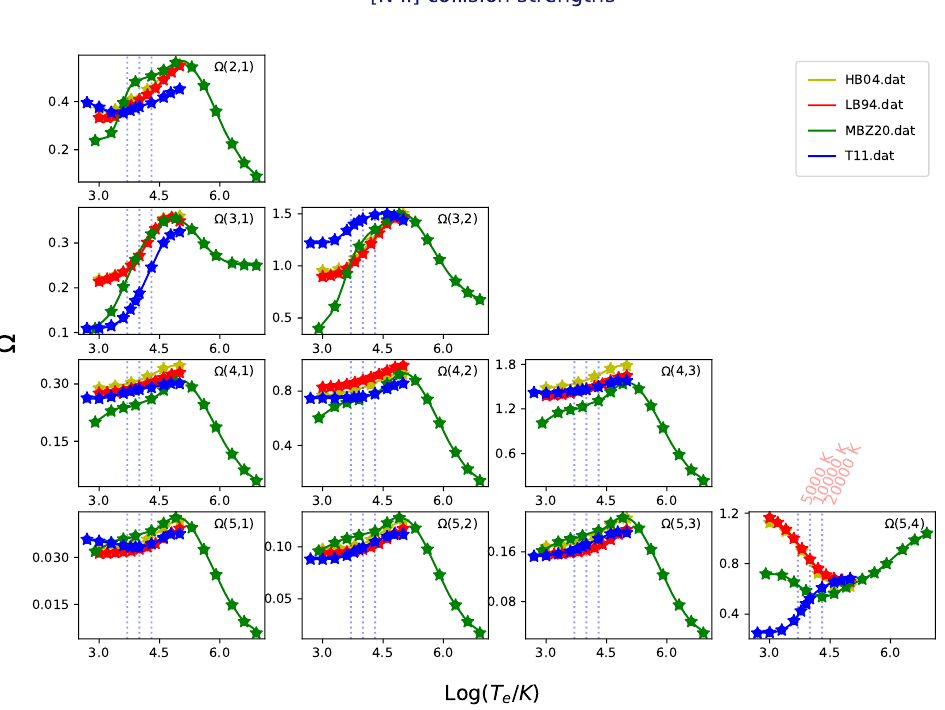
Figure 11. Available ECS for N II in PyNeb plotted with the plotOmega method of the DataPLot class. Note that “collision strengths” and Ω ( k , i ) in this figure stand for temperature-dependent